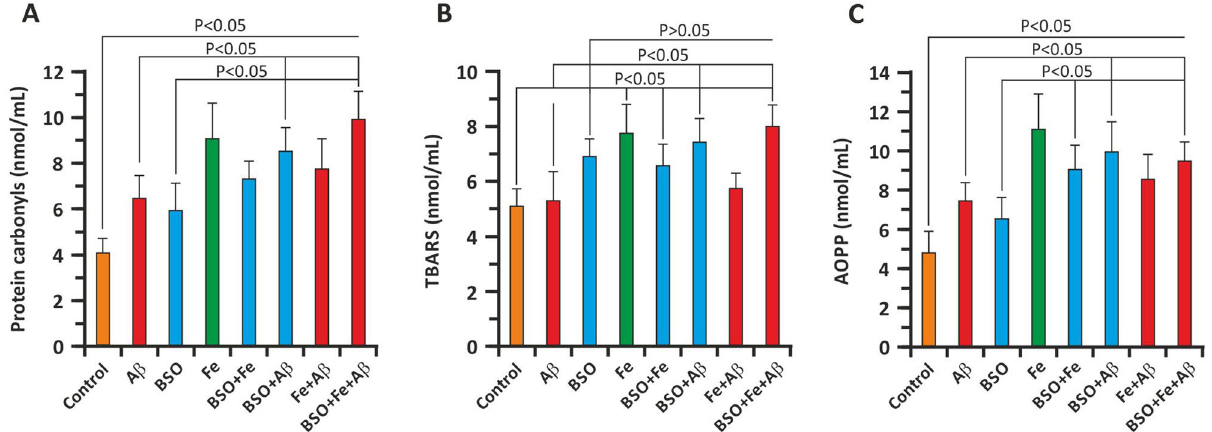
Figure 4. Effect of Aβ, BSO, and Fe 2+ on indicators of oxidative damage in hippocampal cells. ( A ) Carbonylation of cellular proteins. ( B ) Lipid oxidation product (TBARS) levels. ( C ) AOPP levels. Oxidative parameters were measured in neuronal cell lysates on the 3rd day of culture. n = 10. The error bars indicate the mean ±